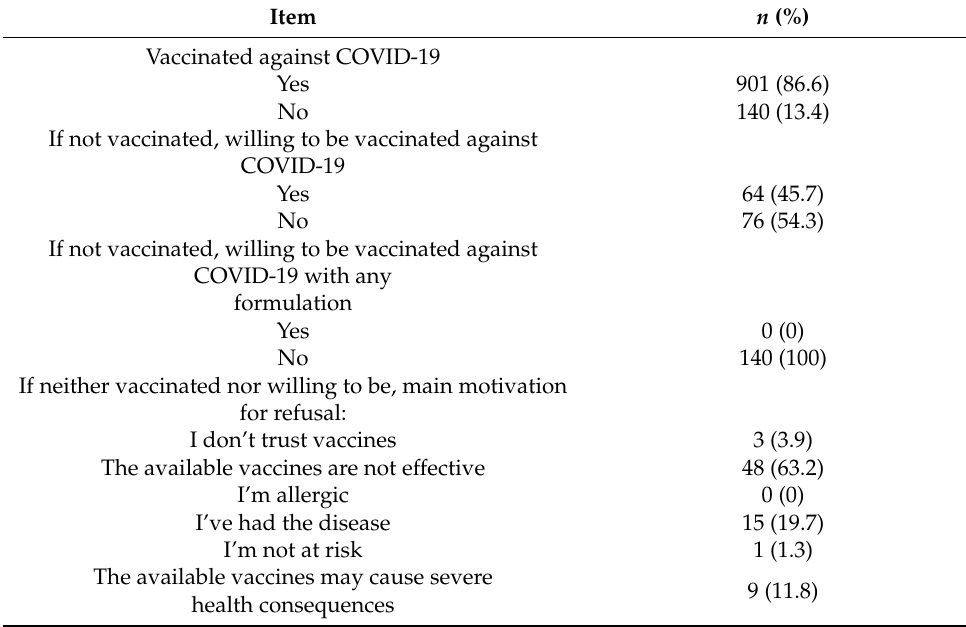
Table 1. Answers related to COVID-19 vaccination provided by participants.